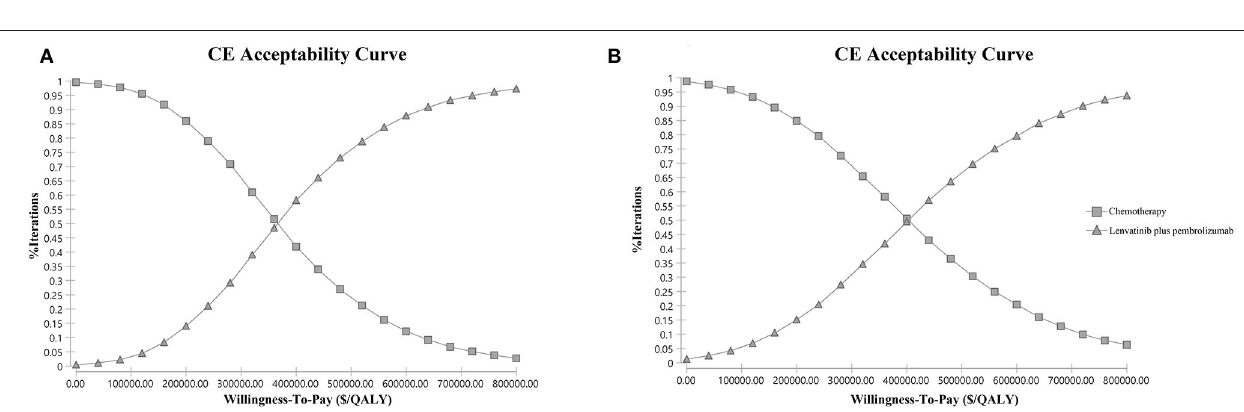
FIGURE 3 | Probabilistic sensitivity analysis. (A) Overall study population. (B) the pMMR subgroup. The cost-effectiveness acceptability curve indicates the probability ( y -axis) of lenvatinib plus pembrolizumab being cost-effective compared with chemotherapy given the threshold value ( x -axis). CE, cost-effectiveness; QALY, quality-adjusted life